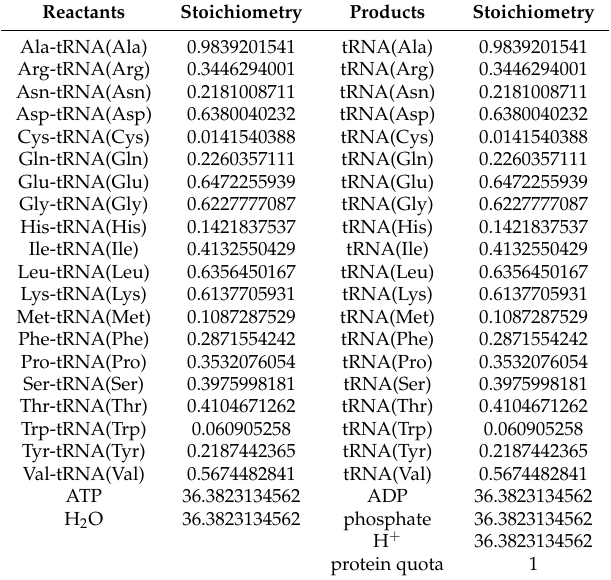
Table A4. Helper reaction for producing the protein quota in the Yeast 6.06